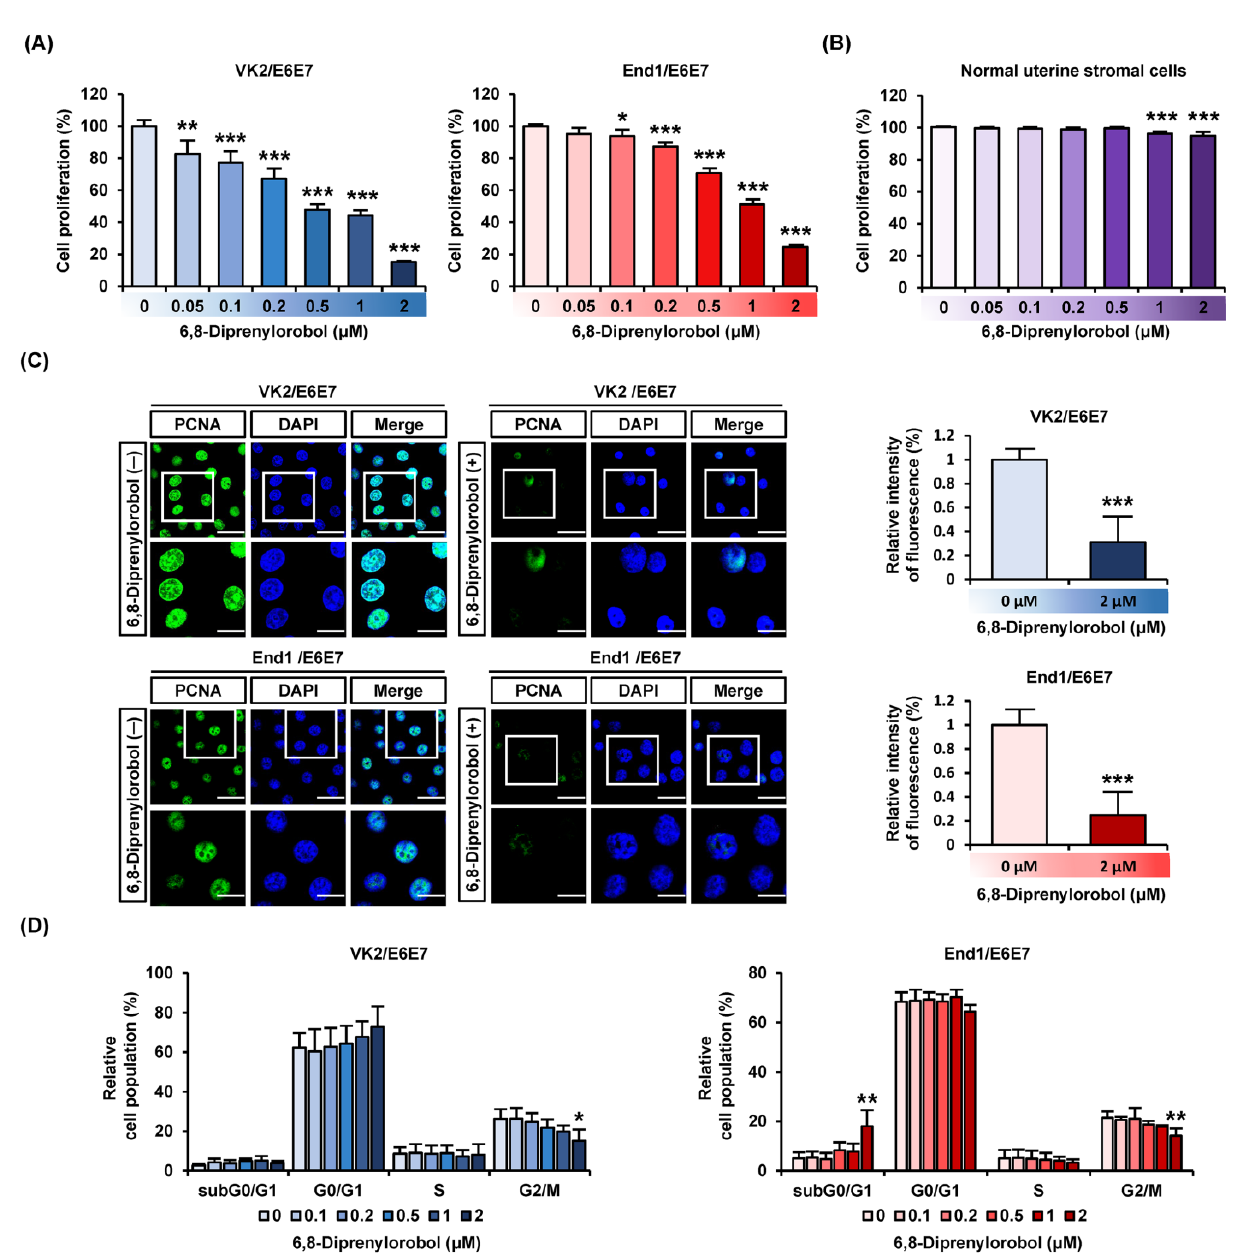
Figure 1. Antiproliferation effects of 6,8-diprenylorobol in human endometriosis cells. ( A ) Cell pro- liferation of VK2/E6E7 and End1/E6E7 in response to various concentrations of 6,8-diprenylorobol (0, 0.1, 0.2, 0.5, 1, and 2 μM) was conducted. Average values of triplicated data were converted to relative ratio values and represented in a bar graph. ( B ) Proliferation of normal uterine stromal cells was treated with 6,8-diprenylorobol. ( C ) Confocal images of VK2/E6E7 and End1/E6E7cells were captured. Green fluorescence indicated PCNA, and blue fluorescence indicated DAPI. The relative intensity of fluorescence between the vehicle and 6,8-diprenylorobol (2 μM) treatment was repre- sented as a bar graph. ( D ) Cell cycle arrest of VK2/E6E7 and End1/E6E7 cells was affirmed by pro- pidium iodide (PI) by FACS. Asterisks indicate significant levels between vehicle-treated cells and 6,8-diprenylorobol-treated cells (* p < 0.05, ** p < 0.01, and *** p < 0.001).